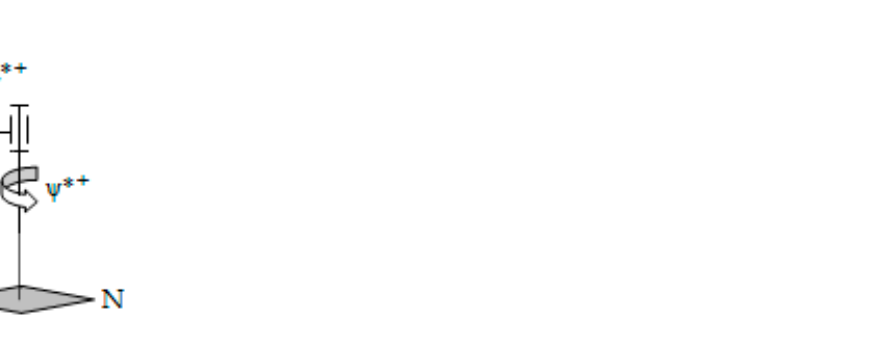
noon, when it faces South. The reference position for the elevation angle ( α * = 0 ◦ ) is the one in which the platform is vertical, the angle being positive ( α * + ) for clockwise rotation.